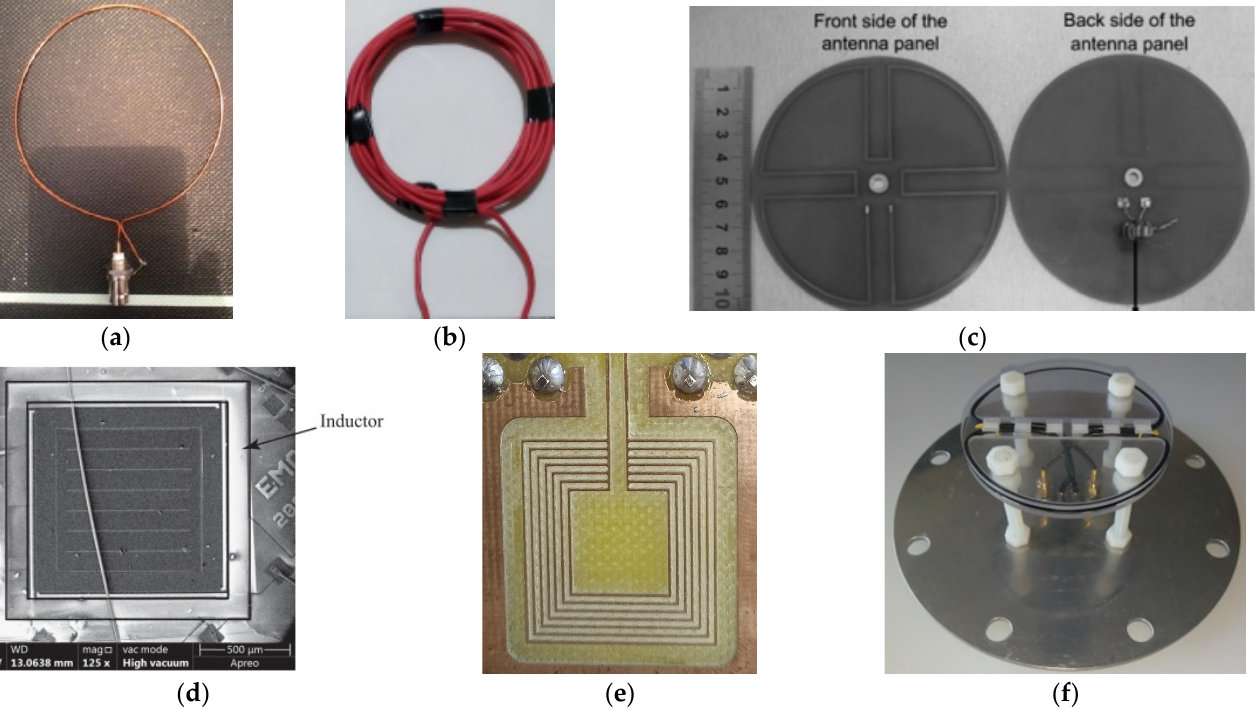
Figure 11. Loop antennas designed for PD detecting by: ( a ) circular loop antenna [60], ( b ) mul ‐ ti ‐ turn circular loop antenna [93], ( c ) antenna panel [95], ( d ) on ‐ chip integrated spiral antenna [95], turn circular loop antenna [93], ( c ) antenna panel [95], ( d ) on-chip integrated spiral antenna [95], ( e ) PCB ‐ based non ‐ spiral inductive sensor [58], and ( f ) single turn magnetic loop antenna [96]. ( e ) PCB-based non-spiral inductive sensor [58], and ( f ) single turn magnetic loop antenna